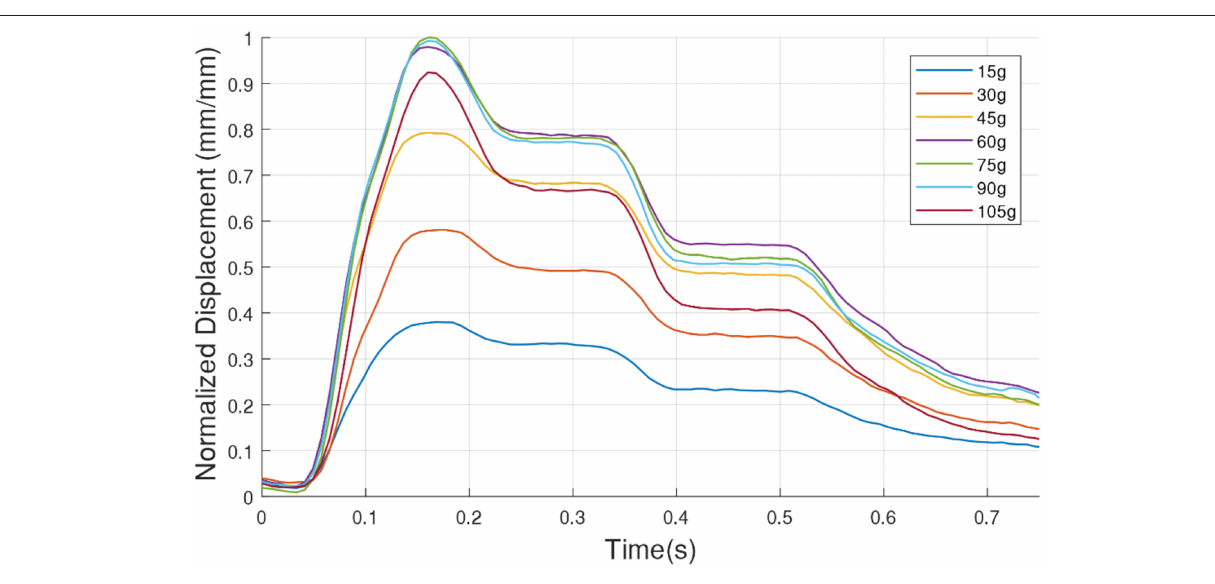
FIGURE 7 | Variations of the normalized displacement (pulse waveform) over time while changing the “hold-down” pressure by varying the mass from 15 to 105g with an increment of